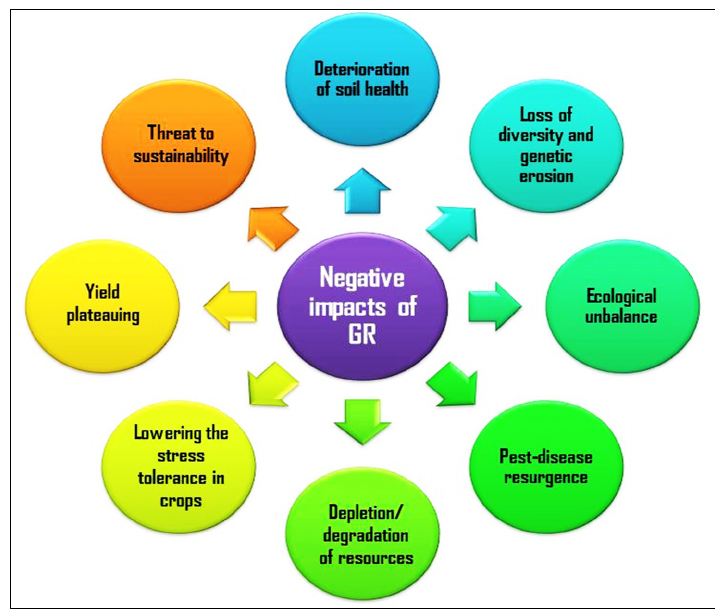
Figure 1. The negative impact of the Green Revolution on agriculture.